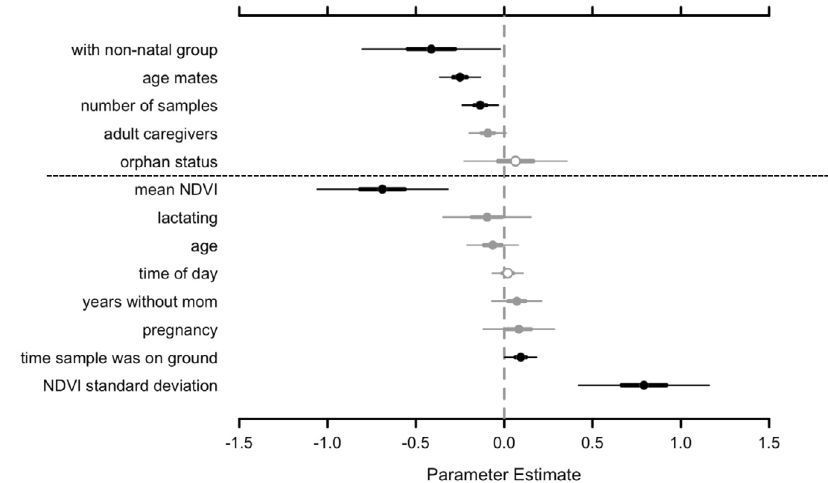
Fig. 2 Coef fi cient values and 95% con fi dence intervals from Bayesian hierarchical regression model ( n = 496 dung samples from 37 elephants). Black denotes estimates whose 95% con fi dence interval did not overlap zero, gray denotes estimates whose 50% con fi dence interval did not overlap zero, and open circles denote variables for which both con fi dence intervals overlap zero. The dotted line separates the fi rst (above line) and second (below line) level of the model. The fi rst level estimated individual-level intercepts, determining the correlation of unchanging variables with mean fecal glucocorticoid metabolite concentrations. The second level used the estimated individual intercepts of the fi rst level to determine the correlation of variables that changed with time according to when a sample was collected. Covariates are ordered according to estimated correlation size, from negative to positive, within each level. NDVI stands for “ normalized difference vegetation index, ” a measure of primary